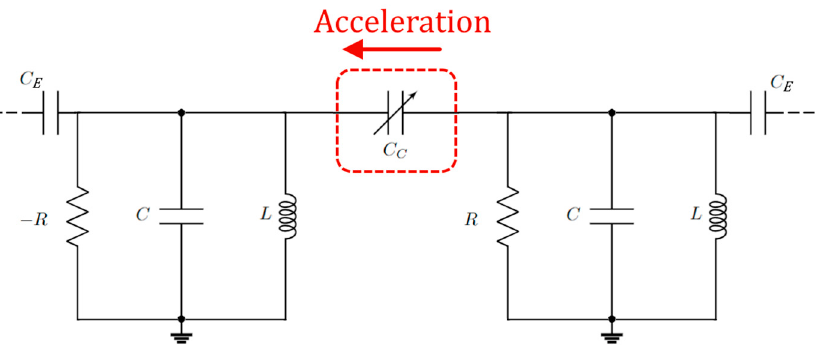
Figure 19. Schematic of the PT-symmetric electromechanical accelerometer proposed in [100]. The PT-symmetric circuit coupled to the transmission line with capacitors C E . The capacitance C C realizes the coupling between the two RLC resonators.